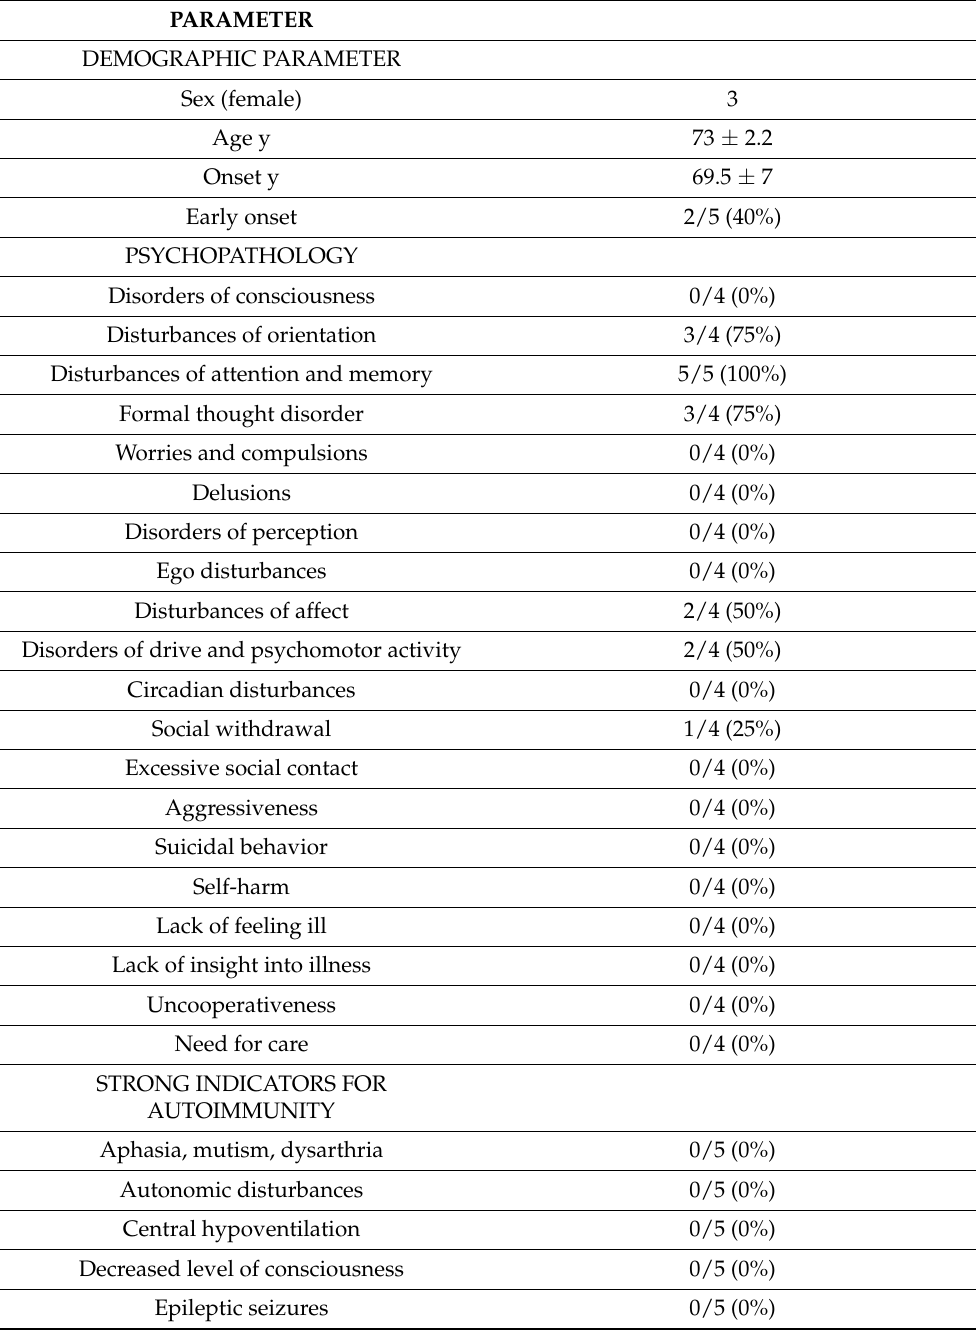
Table 1. Clinical characterization of